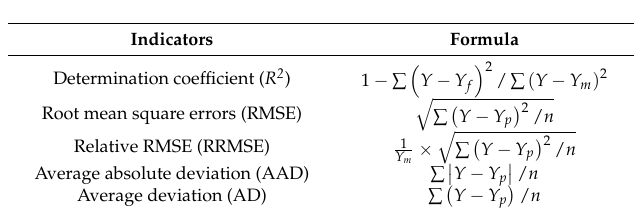
Table 4. Statistical indices for the assessment of the quality of the synthetic